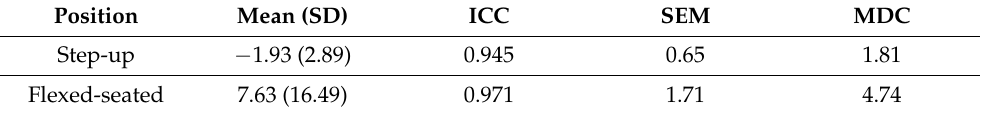
Table 1. Reliability analysis of IMU measurements in different positions.